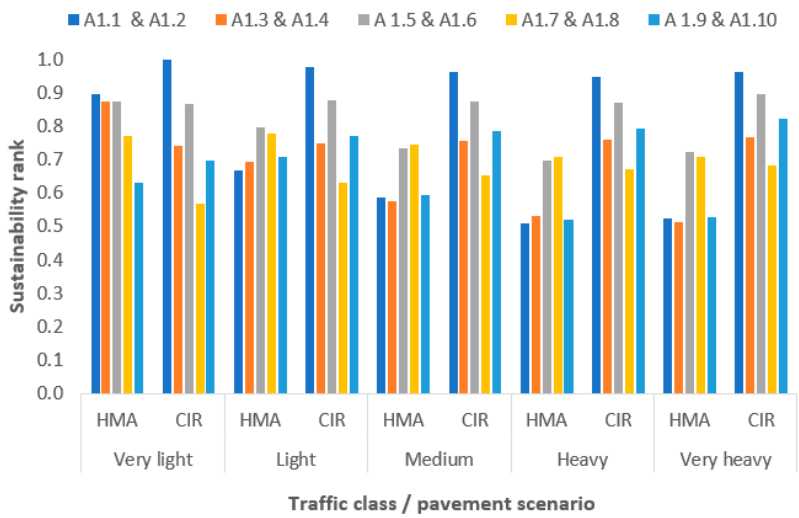
Figure 3. Satiability ranks for all scenarios defined in Table 3. The legend is showing the scenarios’ numbers for the very light traffic class only. The same color scheme is applicable to all traffic classes (also see Table 4).